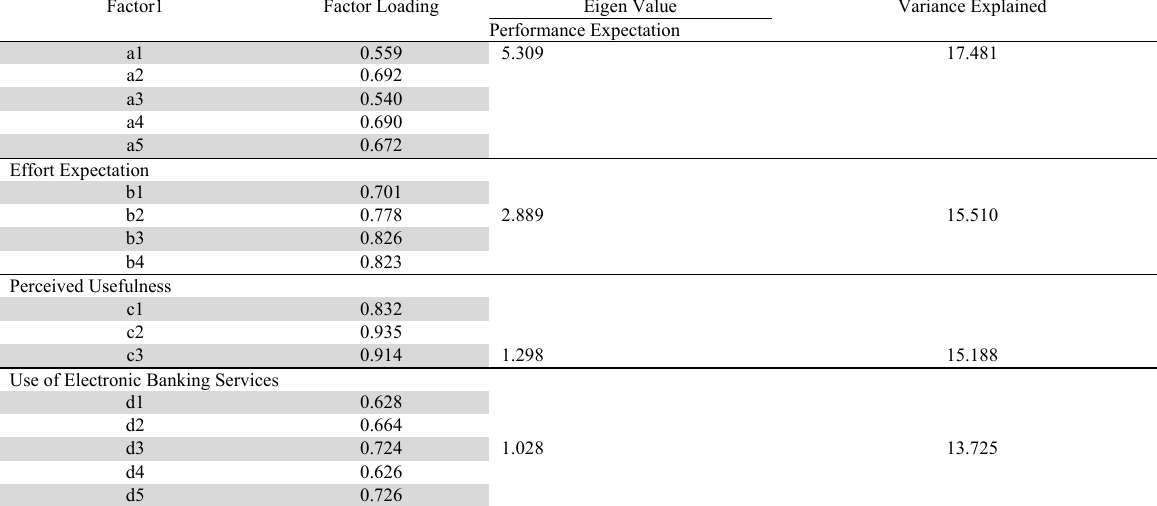
The results of the exploratory factor analysis (EFA) on the 17-item